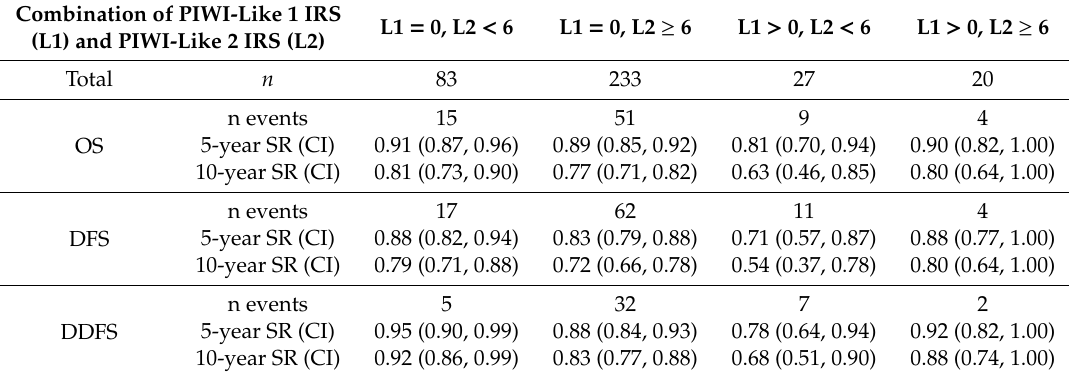
Table 3. Survival rates (5 and 10 years) including 95% confidence intervals for the four combinations of PIWI-like 1 and PIWI-like 2 resulting from the unadjusted model (corresponding to Figures 4–6). Combination of PIWI-Like 1